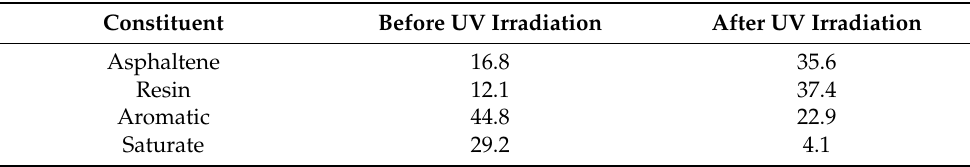
Table 10. SARA analysis result of asphalts and asphalts with TiO 2.